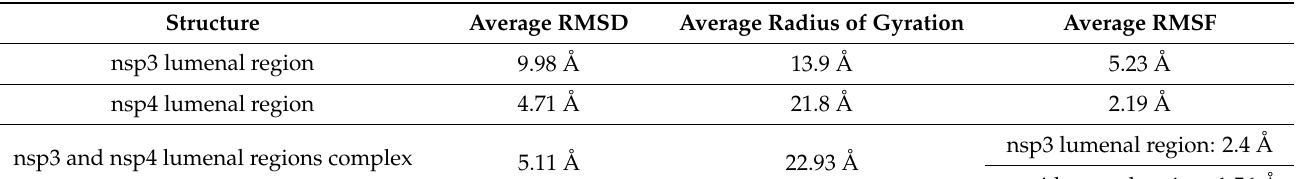
Table 4. Comparison of the average RMSD of the protein backbone, the average radius of gyration, and the average RMSF per residue for each MD